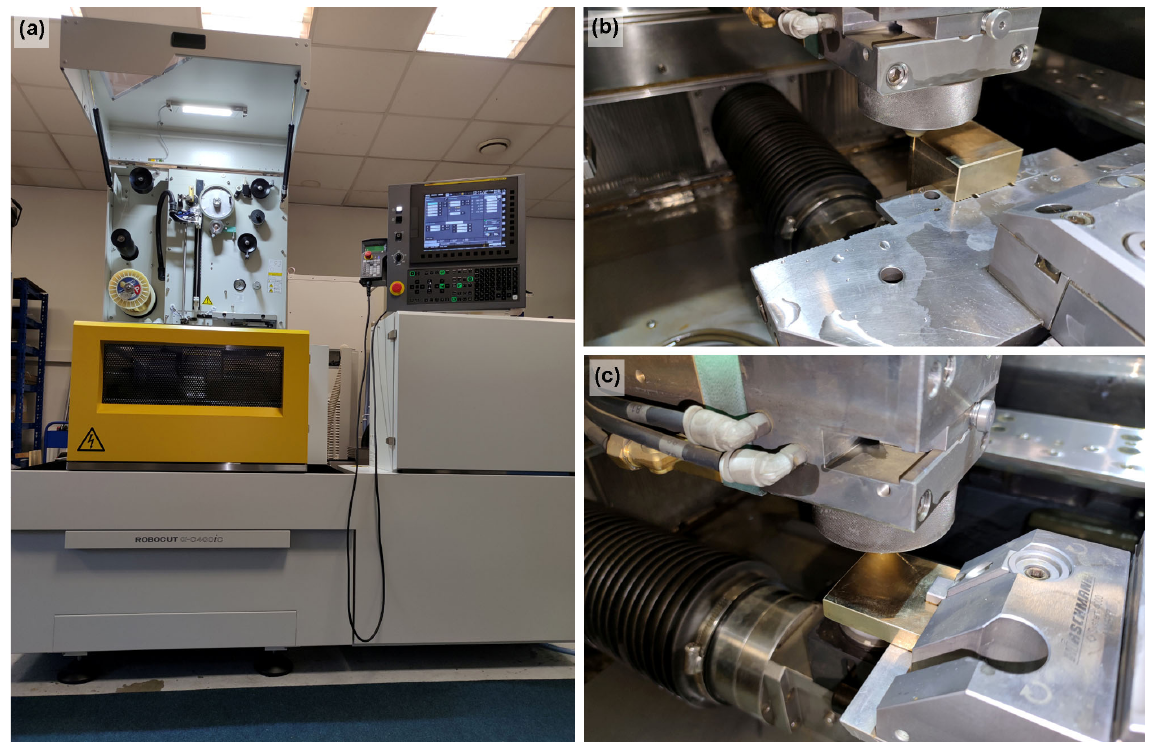
Figure 2. ( a ) Wire ‐ cutting machine FANUC, ( b , c ) sample production. The key output characteristics describing EDM wire cutting are the cutting speed and quality of the machined surface. These will be assessed both in the center of the sample and at its margin. The removal of eroded particles is expected to be poorer in the samples’ center, as the dielectric access to the cutting point is more difficult. As a result, the surface quality will deteriorate. The dependence of these characteristics on the machining param ‐ eters was modelled using a design of experiment (DoE). The ground for this large ‐ scale design of experiment is one replication of the Box–Behnken model with two replications of the center point (Table 1) for the input factors discharge current ( I ), pulse on time ( T on ), and pulse off time ( T off ), and in the ranges according to Table 2. Table 1. The design of the experiment for one material thickness.